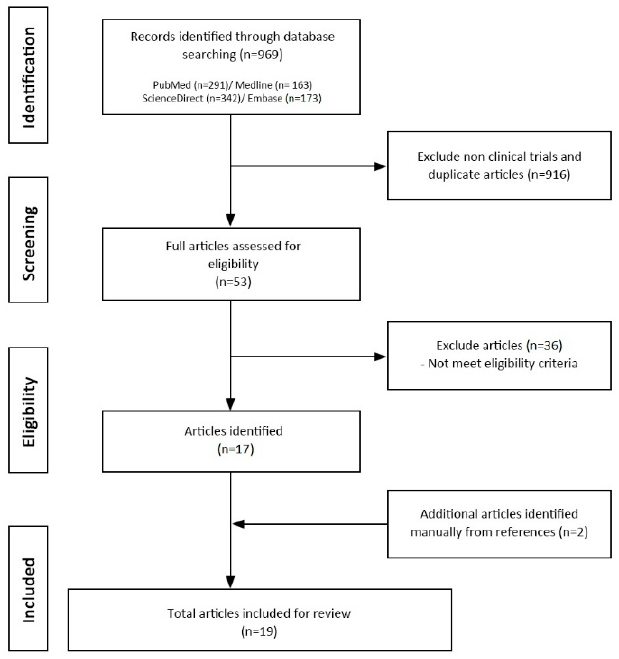
Figure 1. Flow Figure 1. Flow chart.